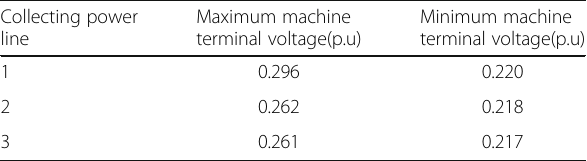
Table 5 Maximum and minimum voltages of the wind turbines connected to the collector network during a three-phase fault Collecting power line